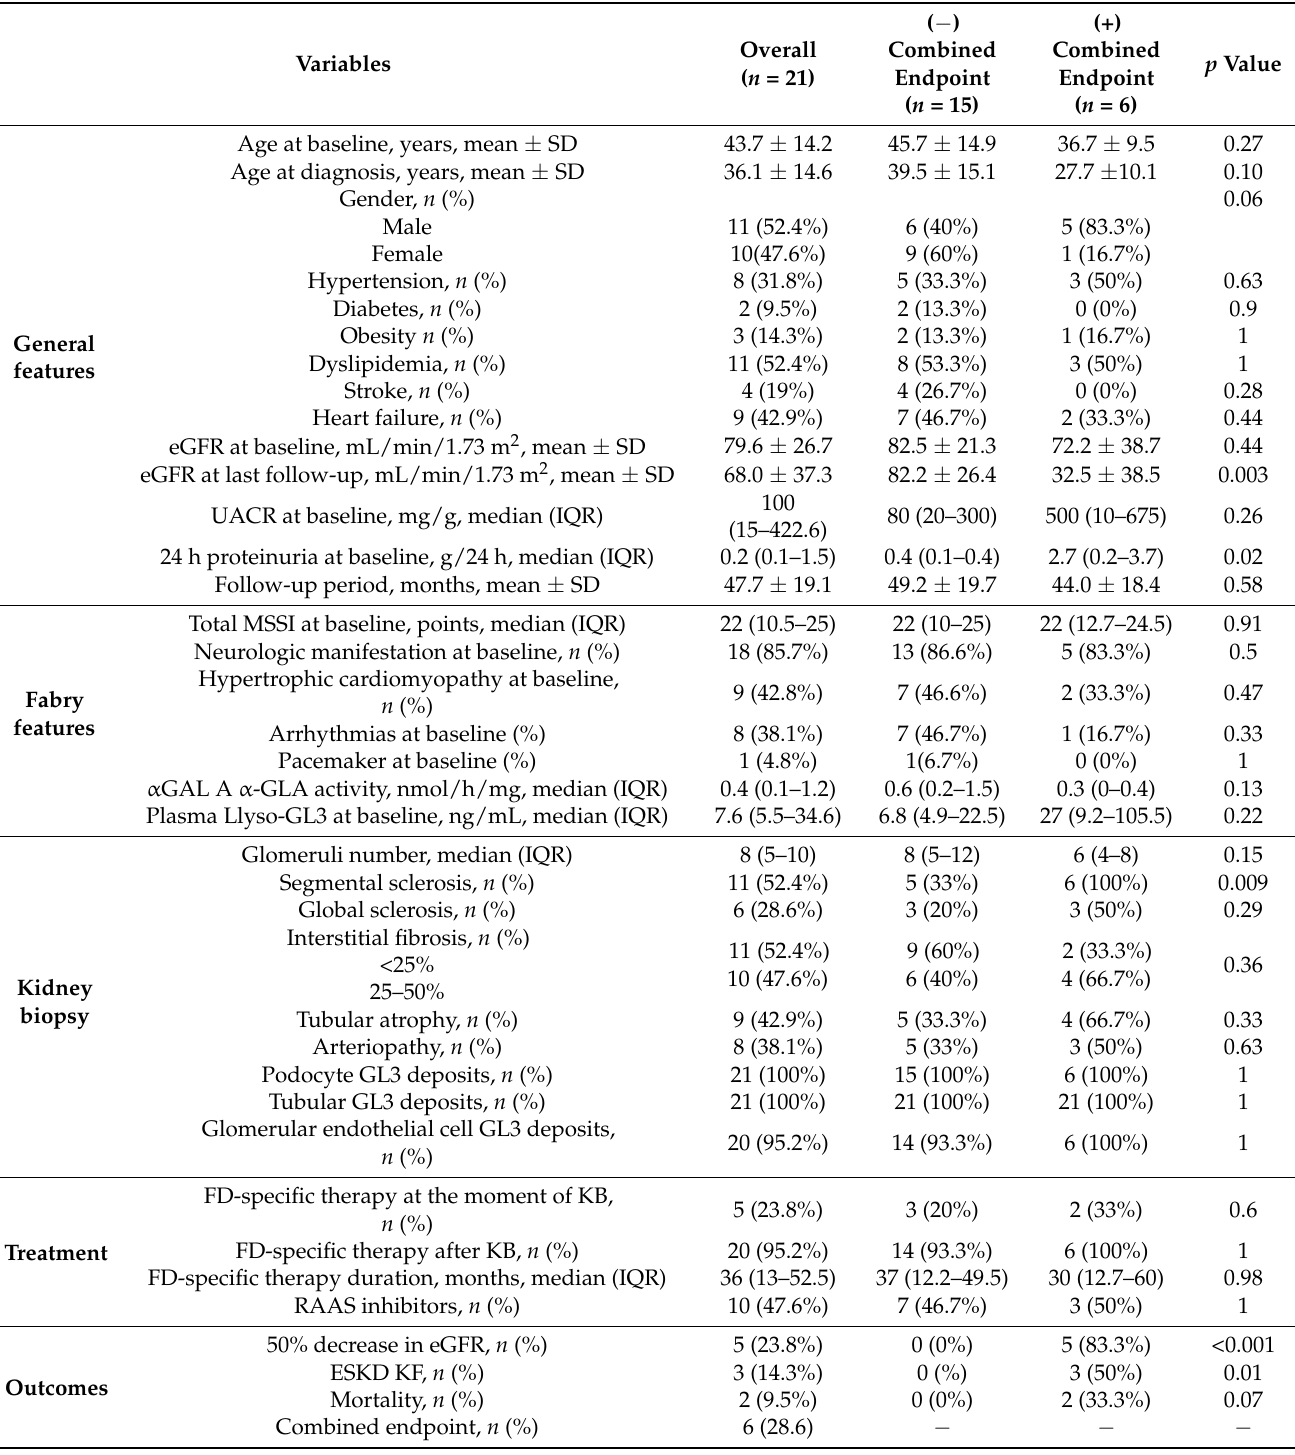
Table 2. Differences between group 1 (negative for the combined endpoint) and group 2 (reaching the combined endpoint) of